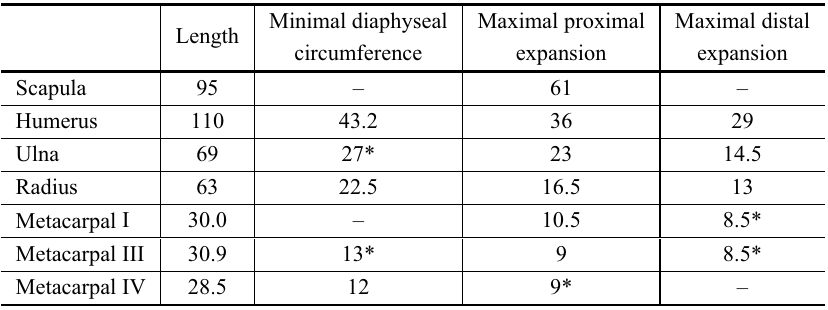
Measurements of Angolatitan adamastor (in